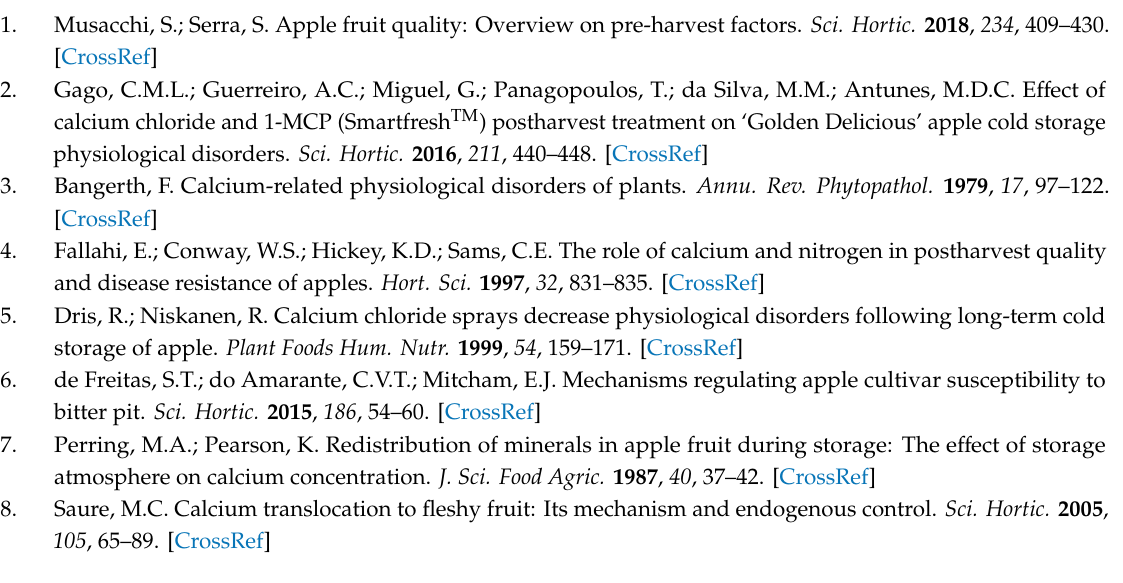
Figure S1. Above: Site 1 orchard (five-year-old Jonathan / M9 apple trees, at a density of 3333 trees ha − 1 . Below: Site 2 orchard (42 year old Jonathan / seedling, at a density of 455 trees ha − 1 ). Figure S2: Meteorological conditions during the growing season 2014 at the Laimburg Research Centre in Ora (Italy). Temperatures (lines) and cumulated monthly rainfalls (columns). Figure S3: Spots development in apple fruits cv. Jonathan a ff ected by “Jonathan spot” disorder. Figure S4. Increased red coloration by seaweed applications (above) as compared to untreated control (below). The pictures were taken before harvest (end of August) in site 1 orchard. Figure S5: Firmness ( a ), total soluble solids ( b ), and acidity ( c ) at harvest and during storage (at 0, 60, 130, and 160 days) as a ff ected by treatments in Site1. Vertical bars indicate mean ± SD, n = 3. Bars without letters indicate no significant di ff erences according to LSD test at p < 0.05. Treatments’ legend: CON, control; CAL, calcium chloride; SIL, Siliforce ® + calcium chloride; SEA, seaweeds + calcium chloride. Figure S6: Firmness ( a ), total soluble solids ( b ), and acidity ( c ) at harvest and during storage (at 0, 60, 130, and 160 days) as a ff ected by treatments in Site 2. Vertical bars indicate mean ± SD, n = 3. Bars without letters indicate no significant di ff erences according to LSD test at p < 0.05. Treatments’ legend: CON, control; CAL, calcium chloride; SIL, Siliforce ® + calcium chloride; SEA, seaweeds + calcium